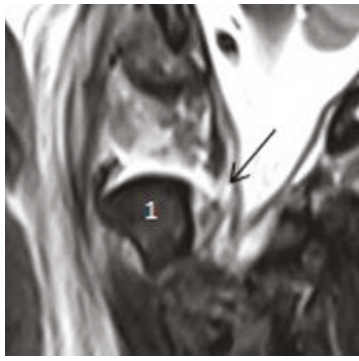
Figure 5: Cervical MRI sagittal view showing the tectorial membrane displaced o ff the dens (1) and a focal disruption of the left aspect (arrow). Note the prevertebral edema.